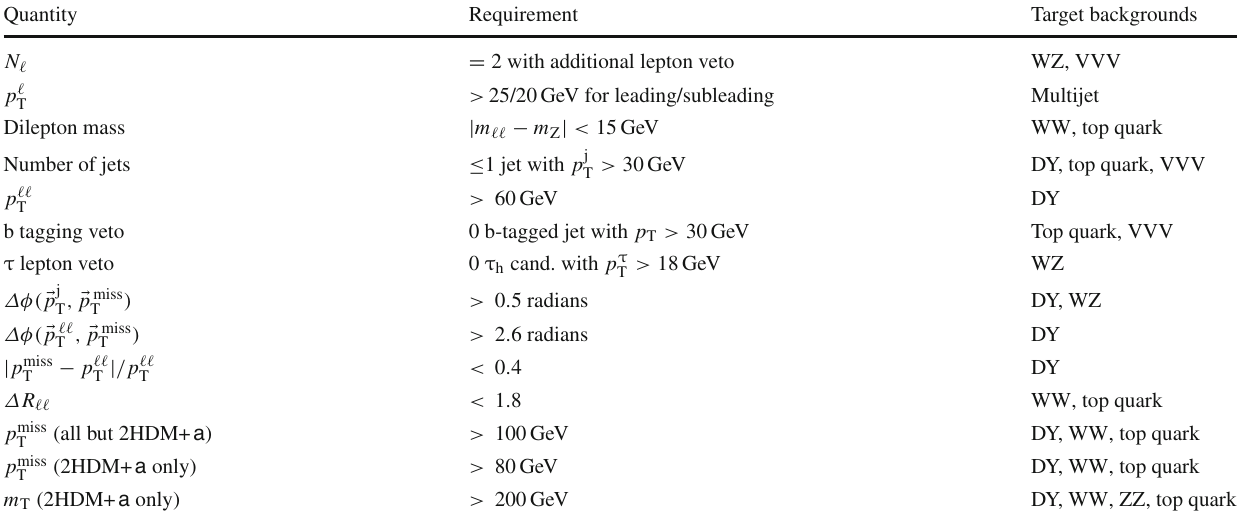
Table 1 Summary of the kinematic selections for the signal region Quantity Requirement Target